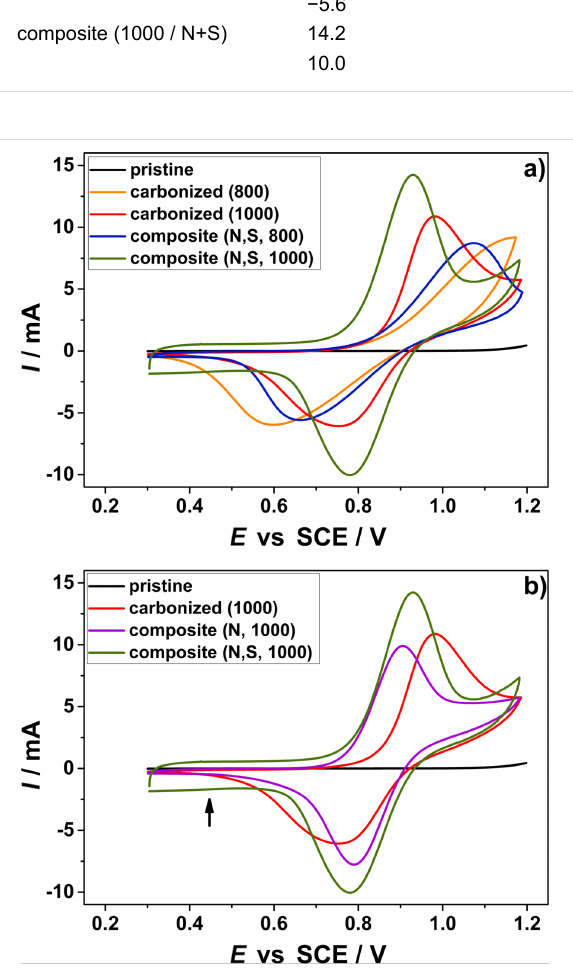
Figure 6: Comparison between the cyclic voltammetry curves of the N-doped (purple) and co-doped (blue, green) composite electrode as well as the carbonized (orange, red) and the pristine (black) felt for the positive half-cell reaction, (a) influence of the temperature used during the treatment and (b) influence of the doping method. The electrolyte consists of 2 M sulfuric acid and additional 0.2 mol/L vanadyl sulfate.